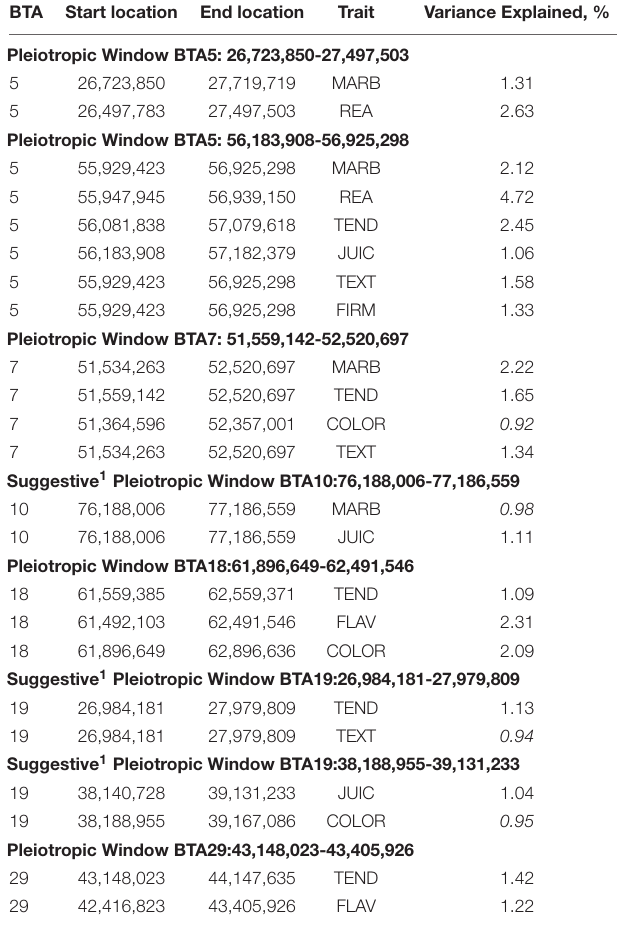
TABLE 4 | Genomic windows explaining more than 1% of direct additive genetic variances and pleiotropic genomic regions associated with carcass quality, sensory meat quality, and visual meat quality traits in a multibreed Angus–Brahman